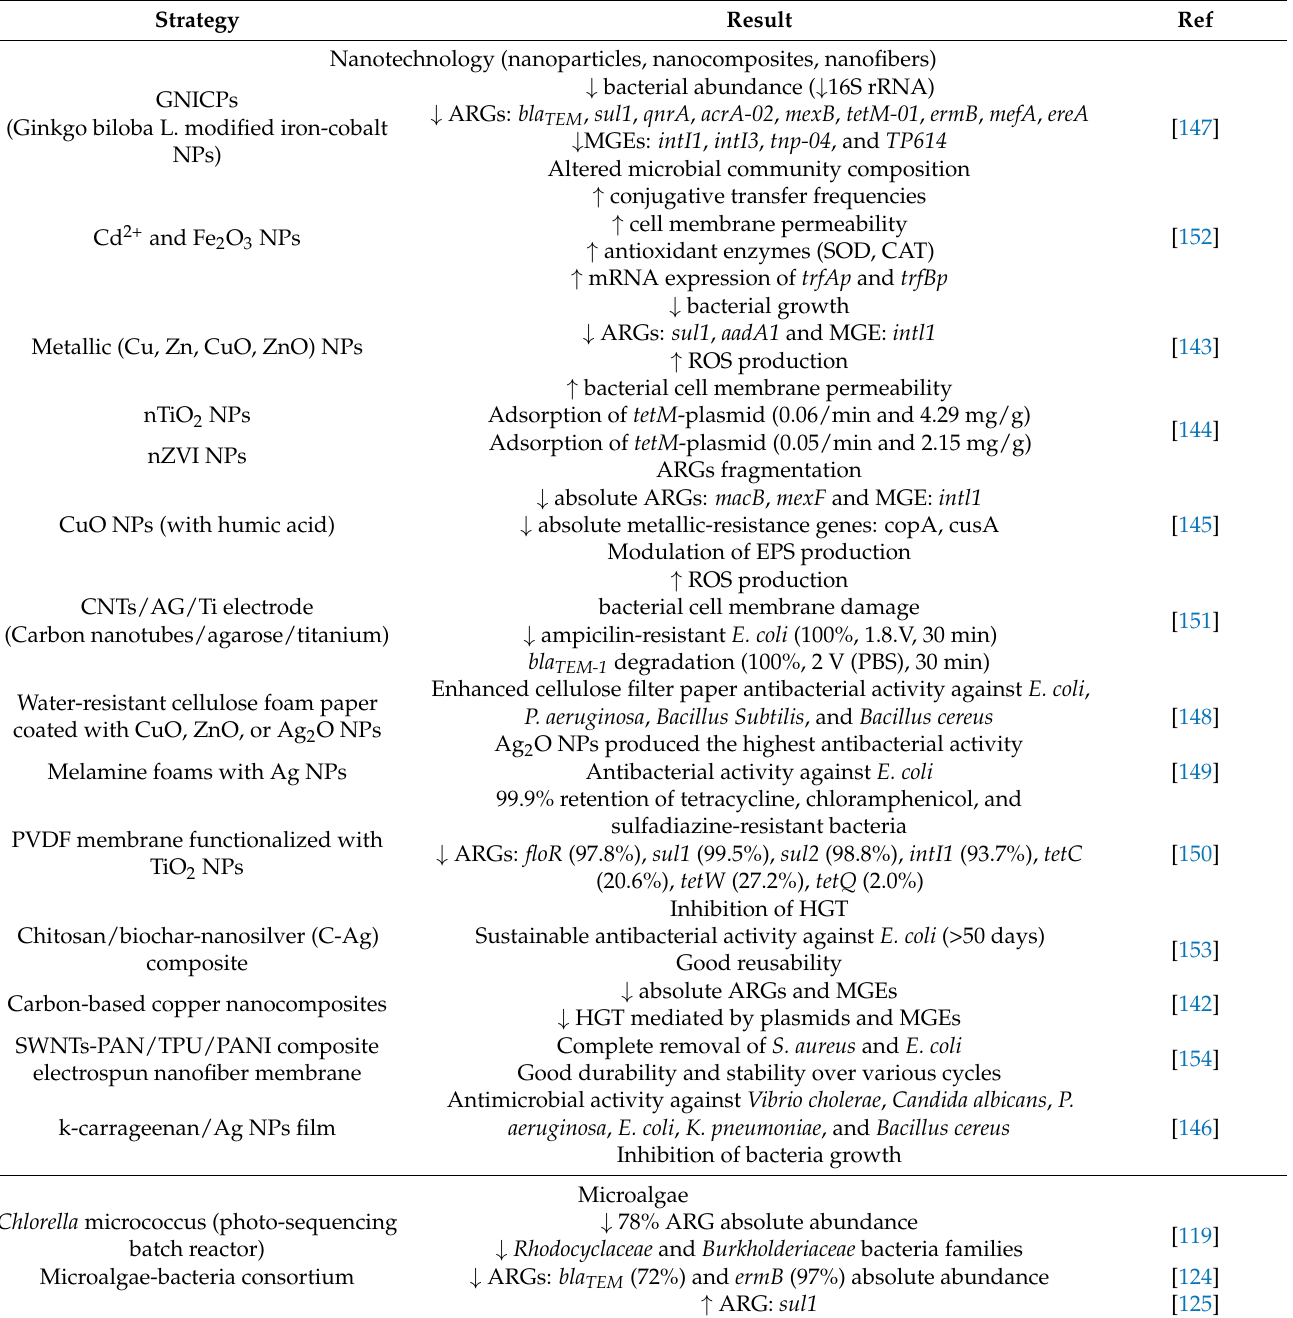
Table 3. Promising strategies to eliminate ARBs and ARGs in water treatment plants and drinking water distribution